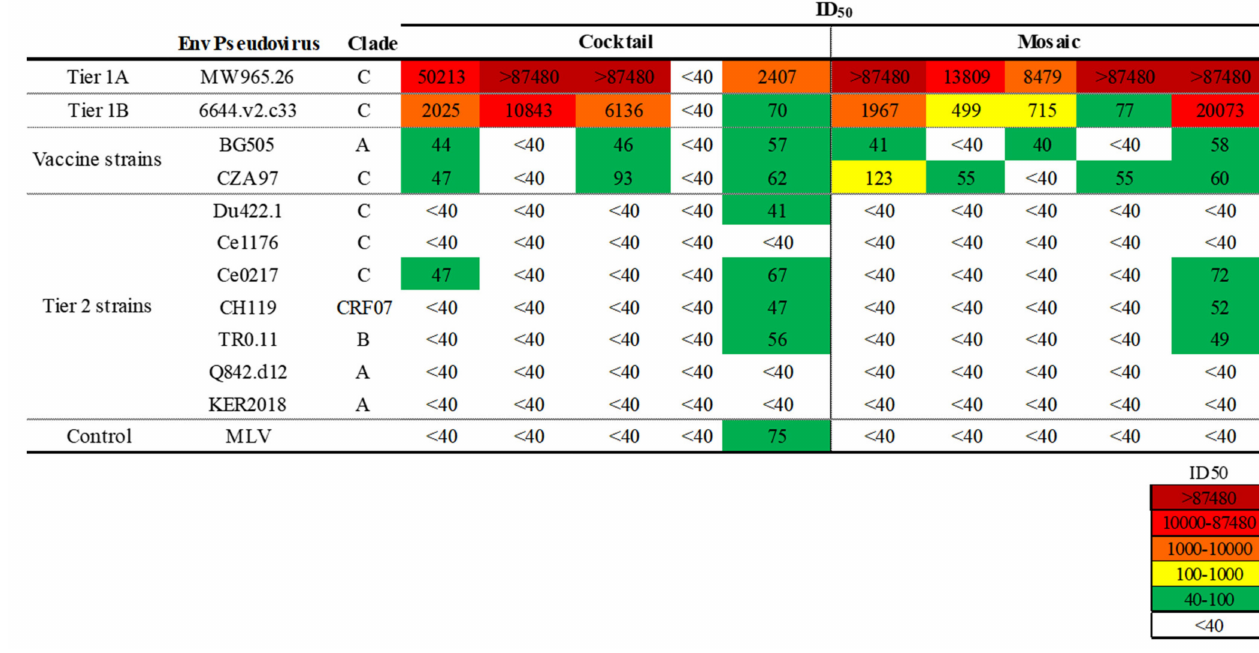
Figure 5. Nanoparticle immunogens elicit vaccine—matched and heterologous neutralization in guinea pigs. Plasma samples collected from guinea pigs ( n = 10) immunized with either single—antigen nanoparticle cocktails or as mosaic nanoparticles bearing both BG505 and CZA97 were tested for neutralization to vaccine—matched, Tier 1, and Tier 2 pseudoviruses. The magnitude of neutralization responses (ID 50 ) is indicated by the color, from higher potency (dark red) to lower potency (green) and no activity